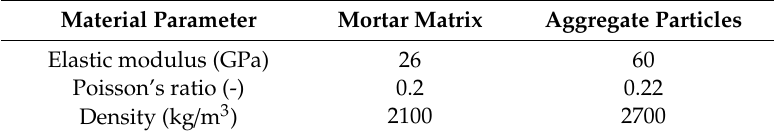
Figure 4. Geometry of numerical models. Table 1. Material parameters of matric mortar and aggregate Table 2. Parameters of numerical models.